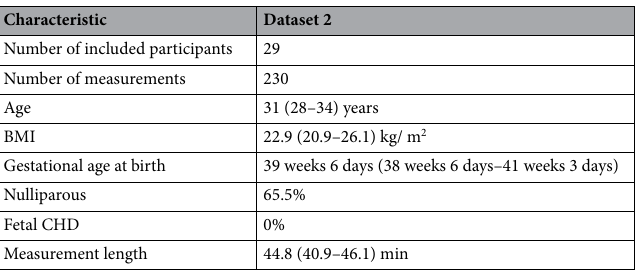
Table 2. Characteristics of Dataset 2. Where applicable, values are represented as median and interquartile ranges.